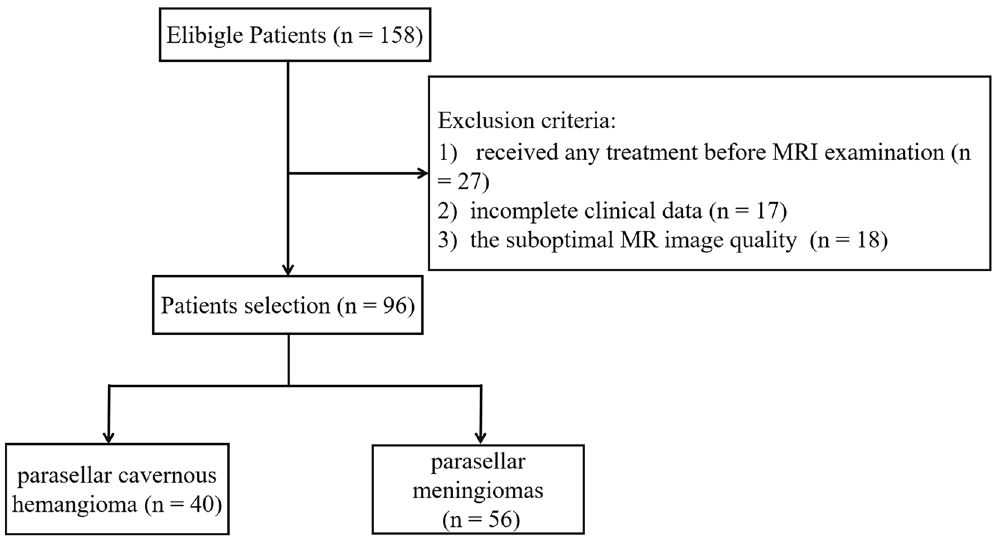
Figure 1. Flowchart for patient selection.